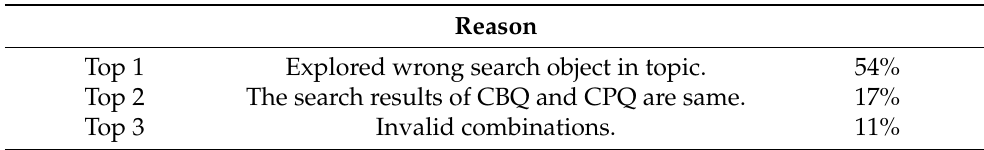
Table 2. Top three mentioned reasons that make QCB